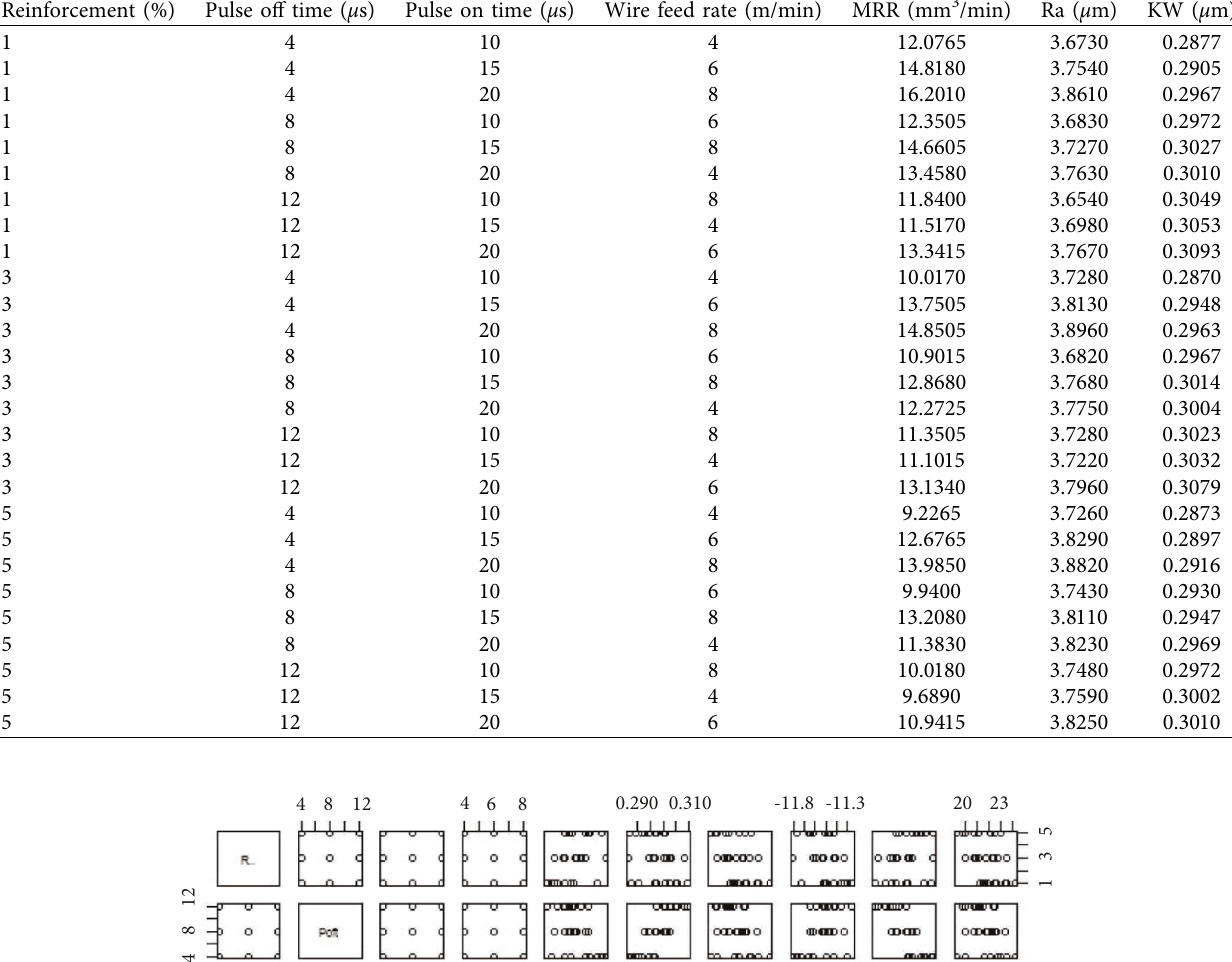
Table 2: Experimental trails along with output response.